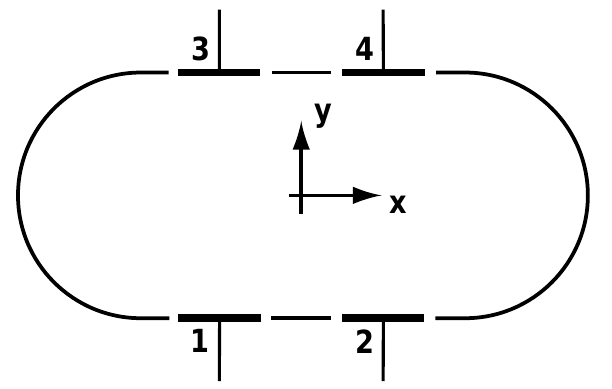
FIG. 3. Typical button layout at a beam position detector.